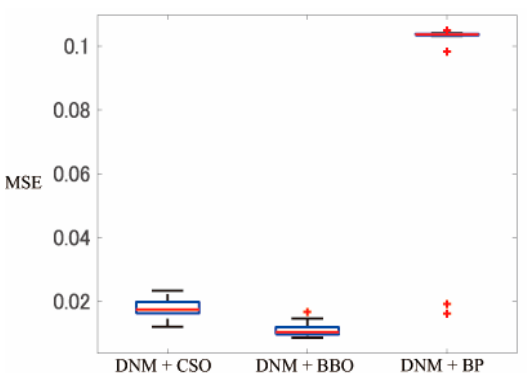
Figure 8. MSE of each method in F3.